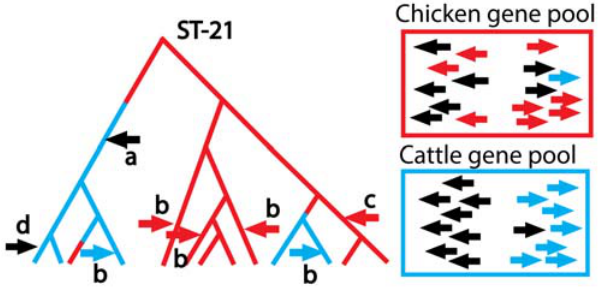
Figure 2. A schematic illustration of the evolution of the C. jejuni ST-21 clonal complex in cattle and chickens. The common ancestor of the complex occurred in chickens (red). During evolution, the lineage occasionally switched to a cattle host (indicated by a blue branch) and sometimes back to chicken. The bacteria acquired DNA by homologous recombination from other C. jejuni in the same host. Since recombination is assumed to occur from donors within the same host, the gene pool is determined by the genomic composition of the strains that colonize each host. The gene pools are illustrated for two separate loci (right and left facing arrows) in chickens and cattle. The gene pools contain alleles whose frequencies occur at much higher frequency in one host than another (shown in colour) and others that did not (shown in black). The former are informative about the host in which the recombination event occurred, while the latter are not. The recombi- nation event labelled a introduces the left facing black arrow gene from the cattle gene pool and is phylogenetically informative because it defines a lineage that is largely restricted to cattle. The five recombination events labelled b are not phylogenetically informative, since they only affect a single strain in the sample. These events are nevertheless informative because they introduce alleles that are characteristic of the host species. The event labelled c is both phylogenetically informative and characteristic of host. The event labelled d is noninformative.